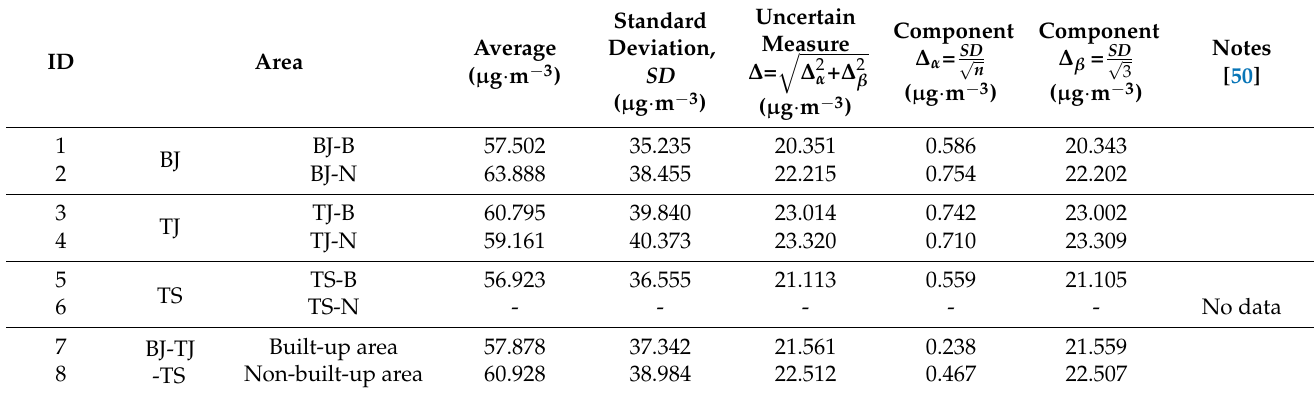
Table 4. Uncertainty analysis for dynamic changes in surface ozone concentration in Beijing, Tianjin, and Tangshan from 2016 to